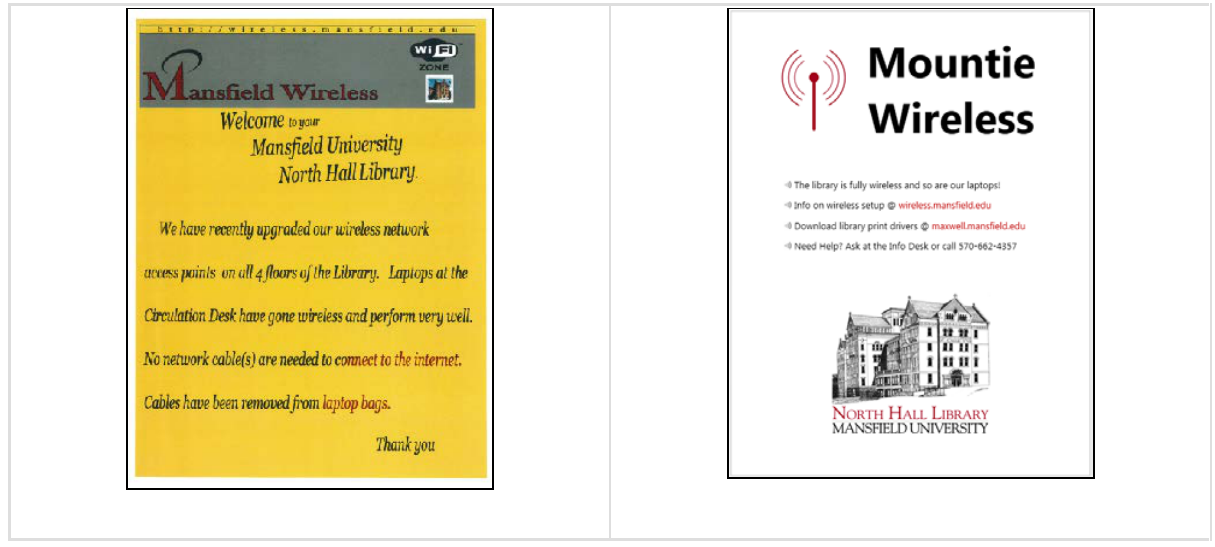
The all italic font and minimal contrast make the original sign (left) difficult to understand. The new version (right), using a bold headline and a bulleted list, is clearer and more